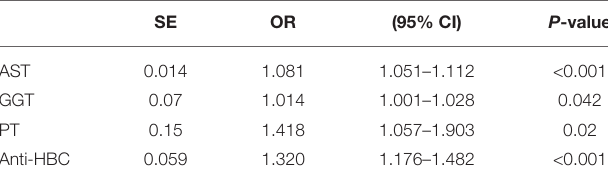
( Table 2 ). Multivariate logistic regression analyses indicated that